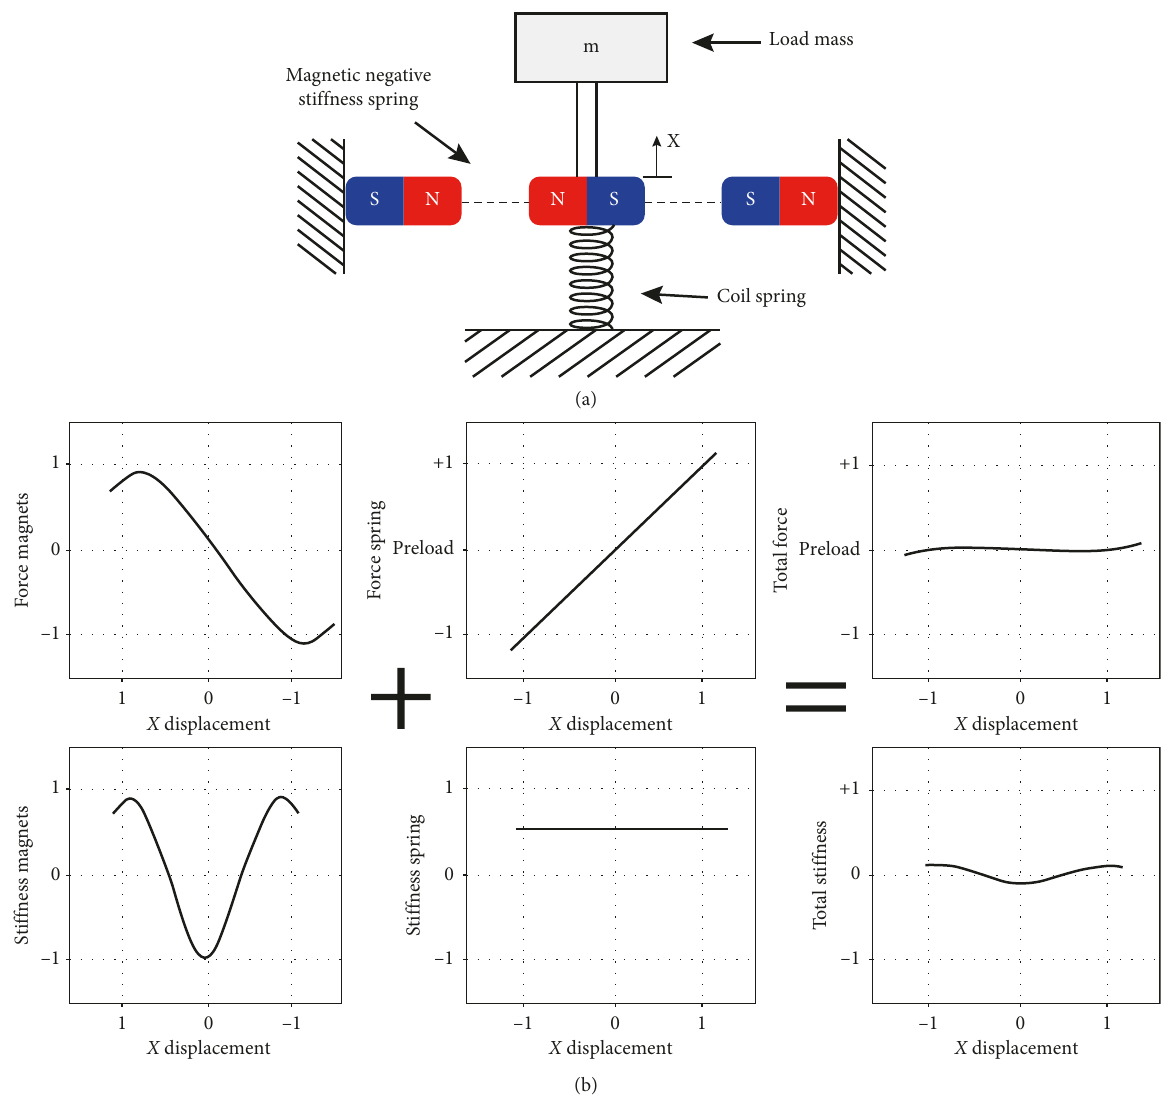
Figure 5: (a) Magnetic negative-stiffness spring configuration with coil spring for static forces. (b) Normalized forces and stiffness against normalized displacements for magnetic spring, coil spring, and its